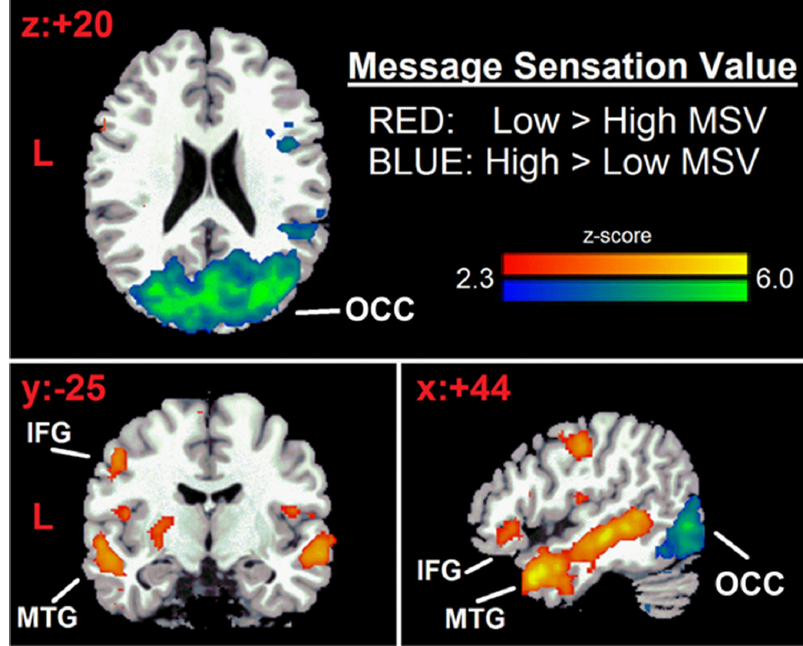
Figure 1. Brain activation in response to different MSVs. Source: [27].